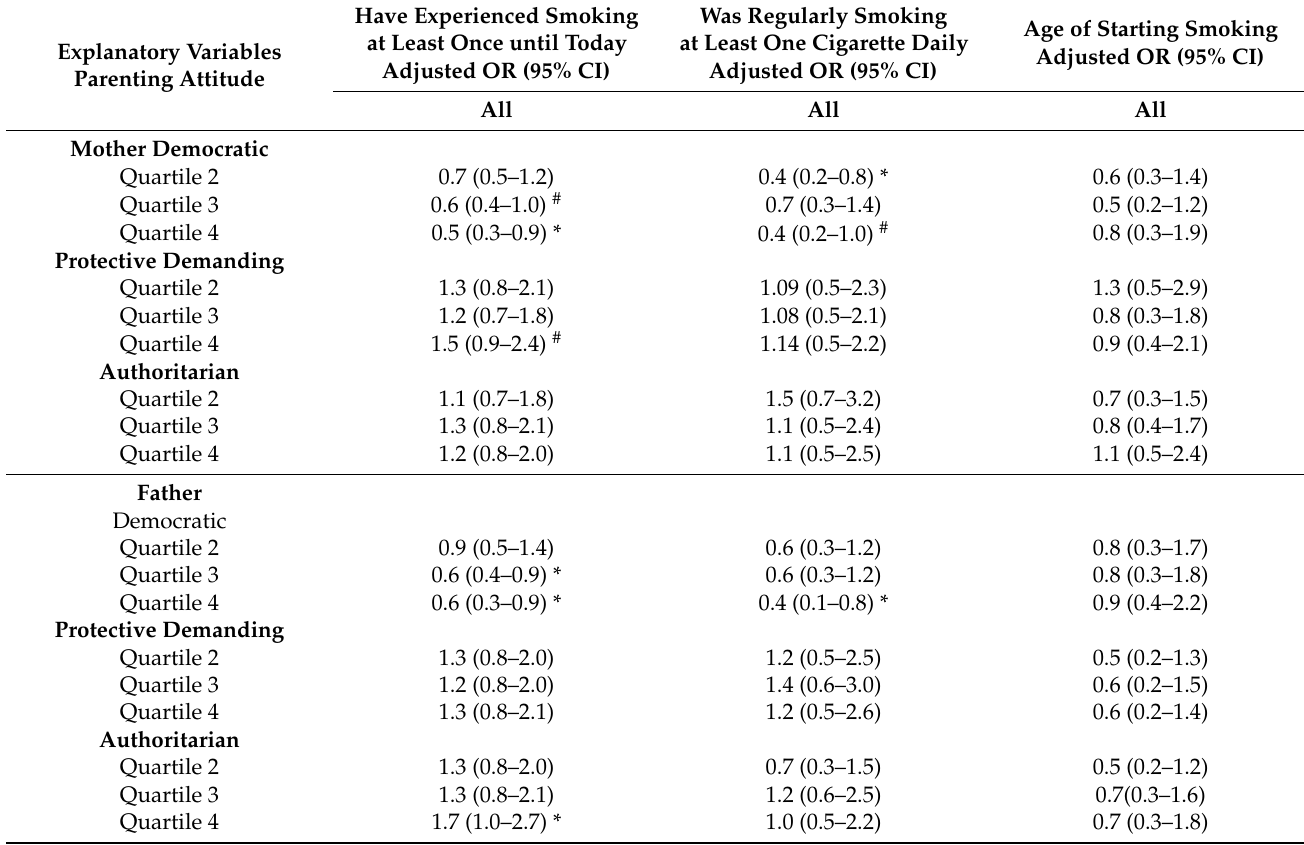
Table 3. Adjusted odds ratio of parental attitude variables for smoking behaviour